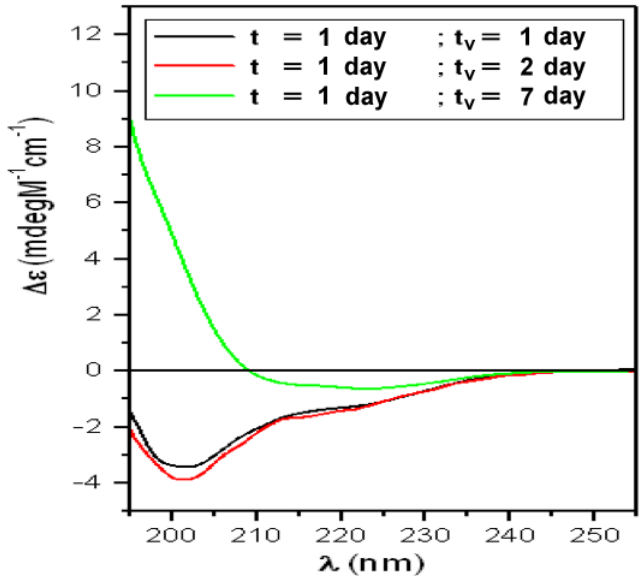
Figure 5. CD spectra relative to sCT solution representing the “Lag-phase” (T1) in the presence of liposomes incorporating GM1 and Chol mimicking “lipid-rafts”. The interaction was studied at room temperature and increasing lifespan (t v ). Table 2. Percentage of the sCT secondary structures obtained by the CD spectrum relative to sCT representing the “Lag-phase” (T1) solution, before and after the interaction with DPPC/Chol/GM1 (spectra of Figure 5).